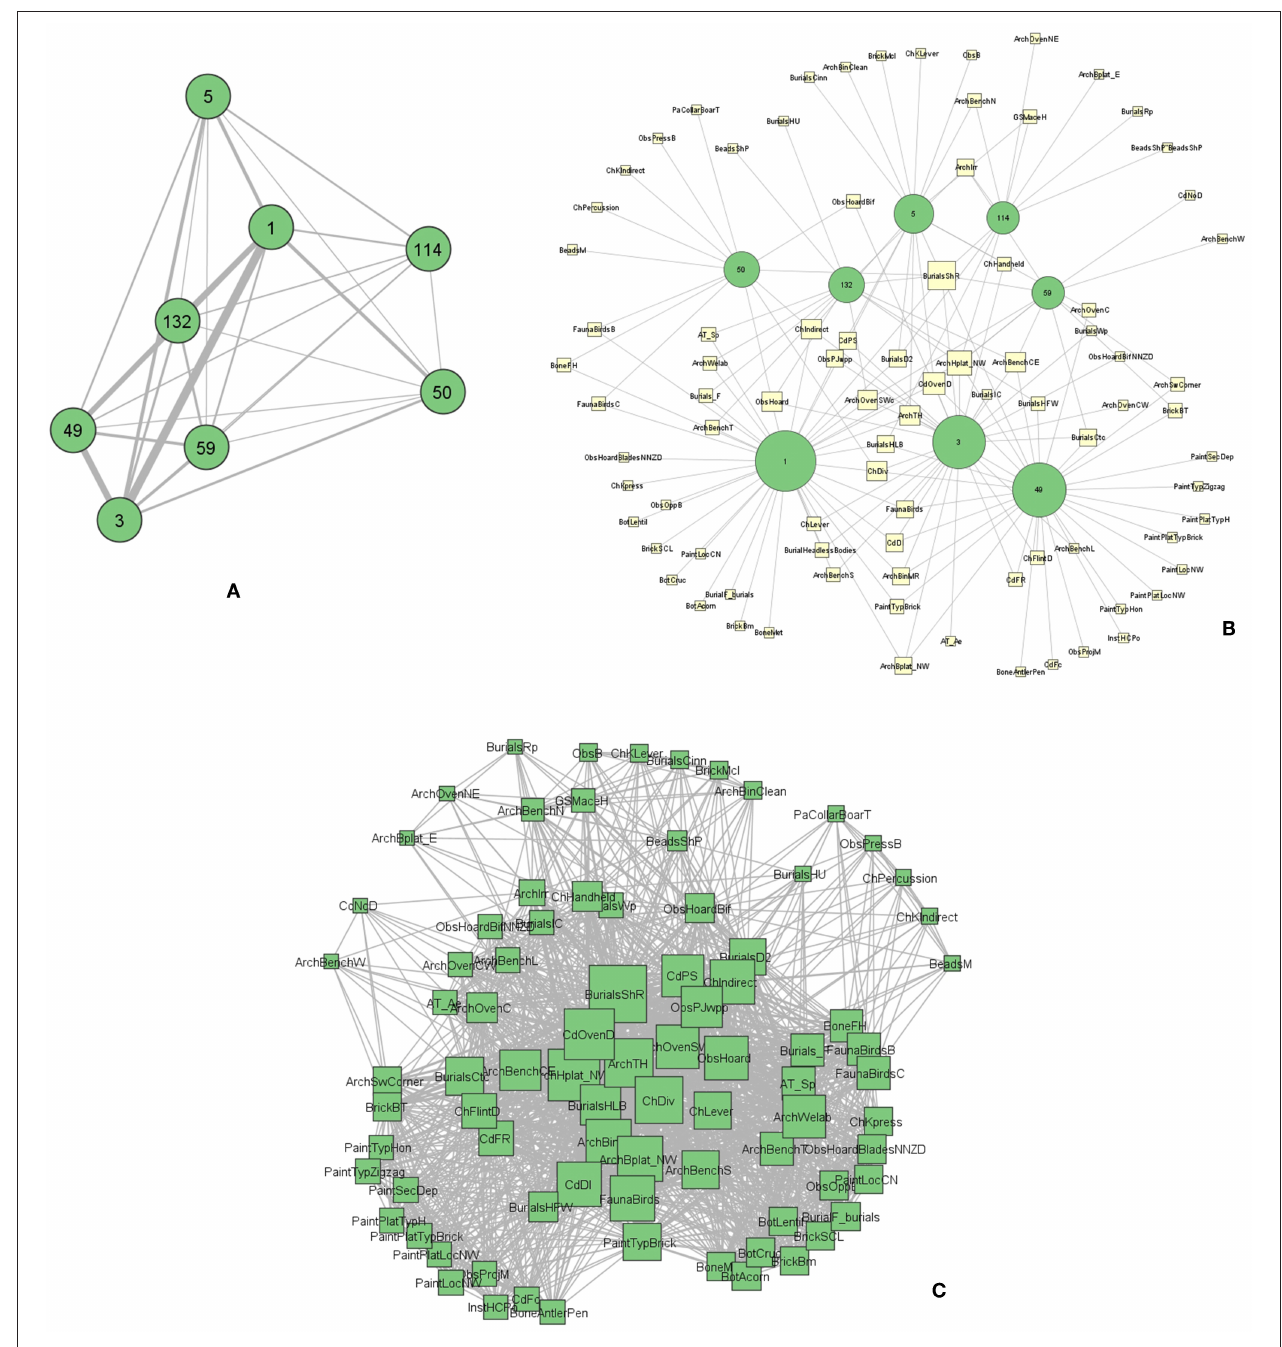
FIGURE 8 | Middle network green module (A) . 2-mode network ( B – size of nodes according to degree centrality) and object network (C) (The codes used are in the Supplementary Material